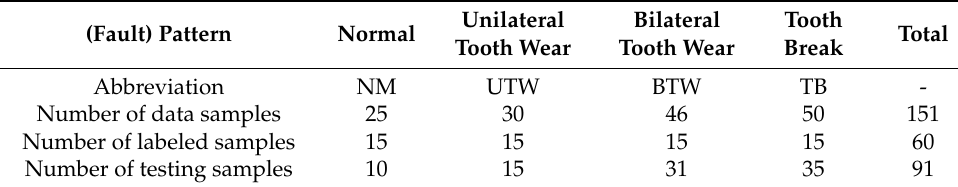
Table 4. Details of dictionary matrix and testing samples.